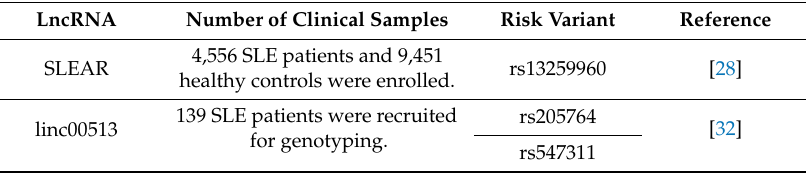
Table 3. Variants within lncRNAs which are associated with risk of